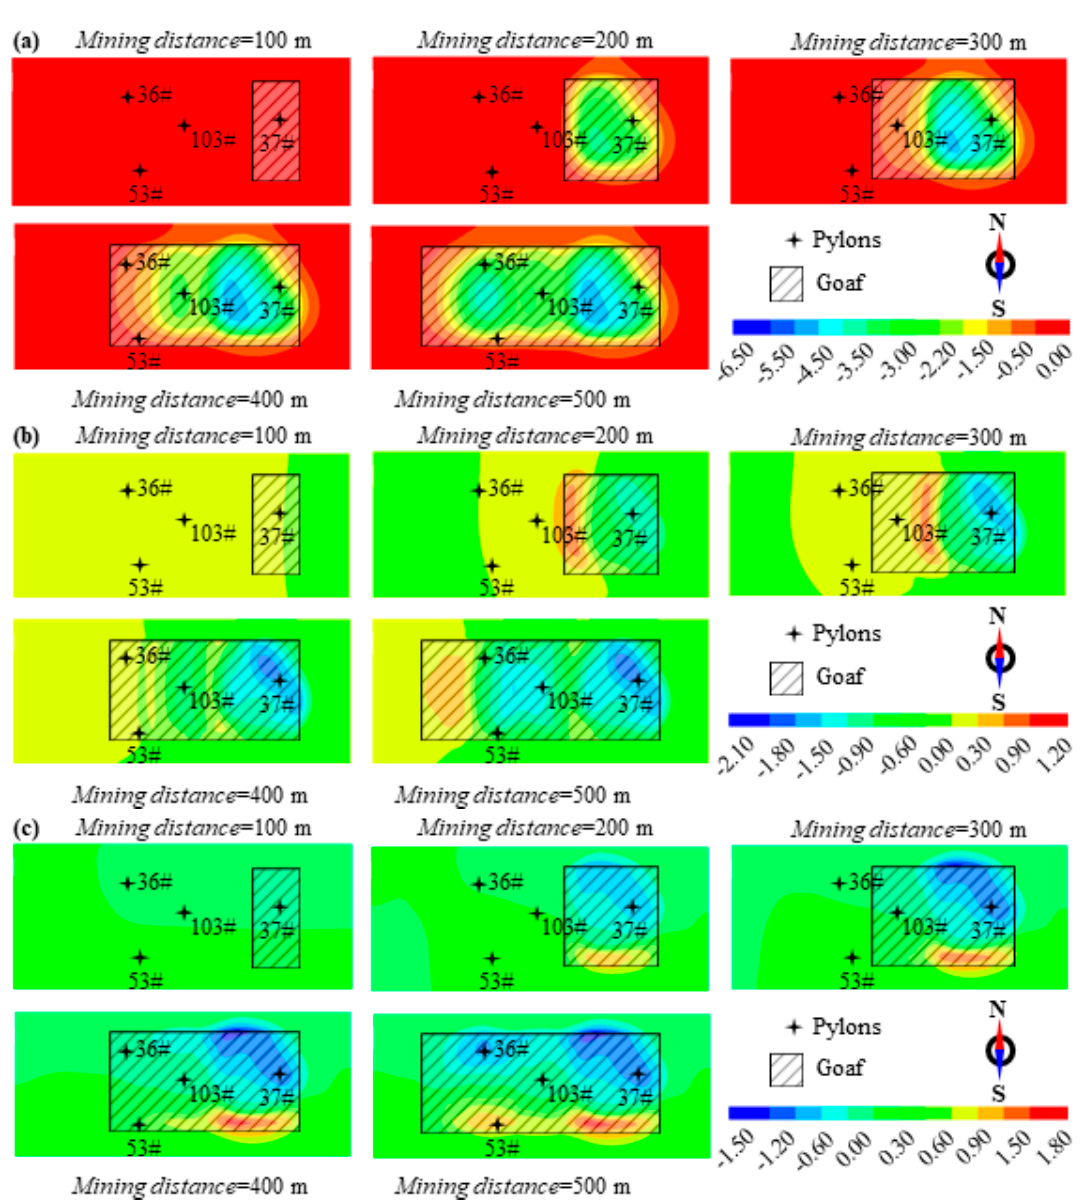
Figure 6. Evolution of surface deformation filed during mining in: ( a ) vertical, ( b ) west–east and ( c ) north–south directions.